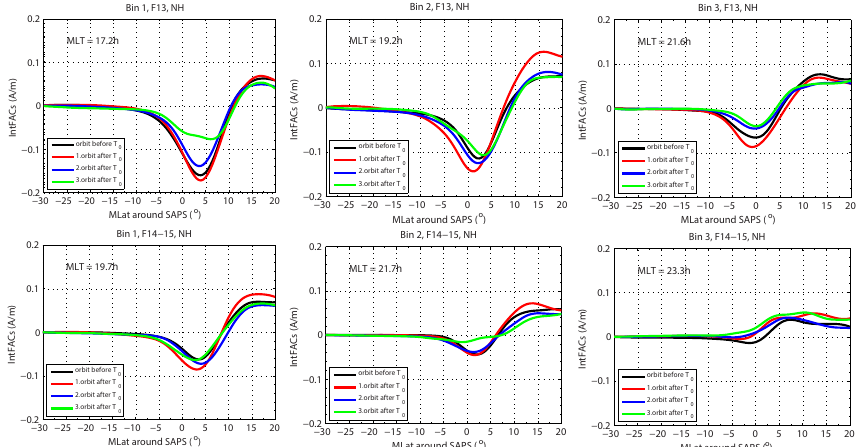
Figure 5. As Fig. 3, but for the integrated